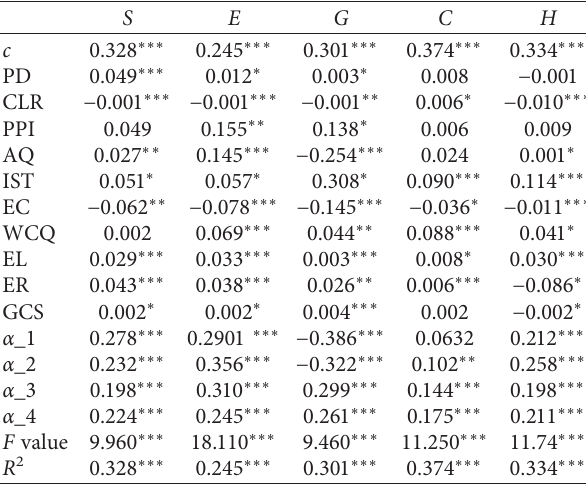
Table 4: Threshold regression